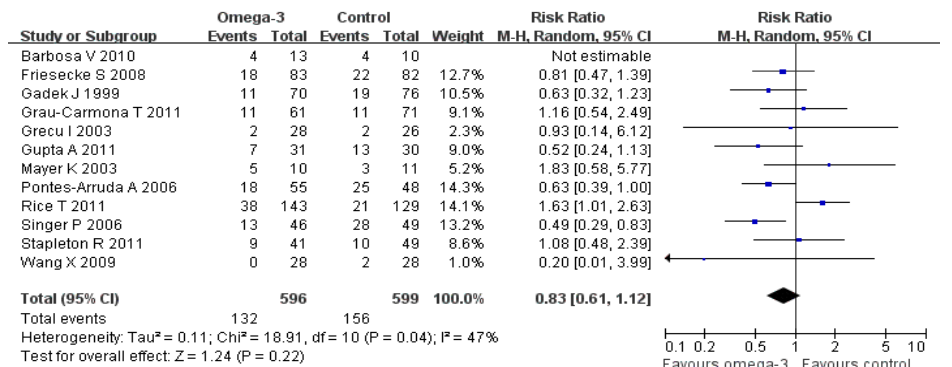
Figure 3. Sensitivity analysis: high quality